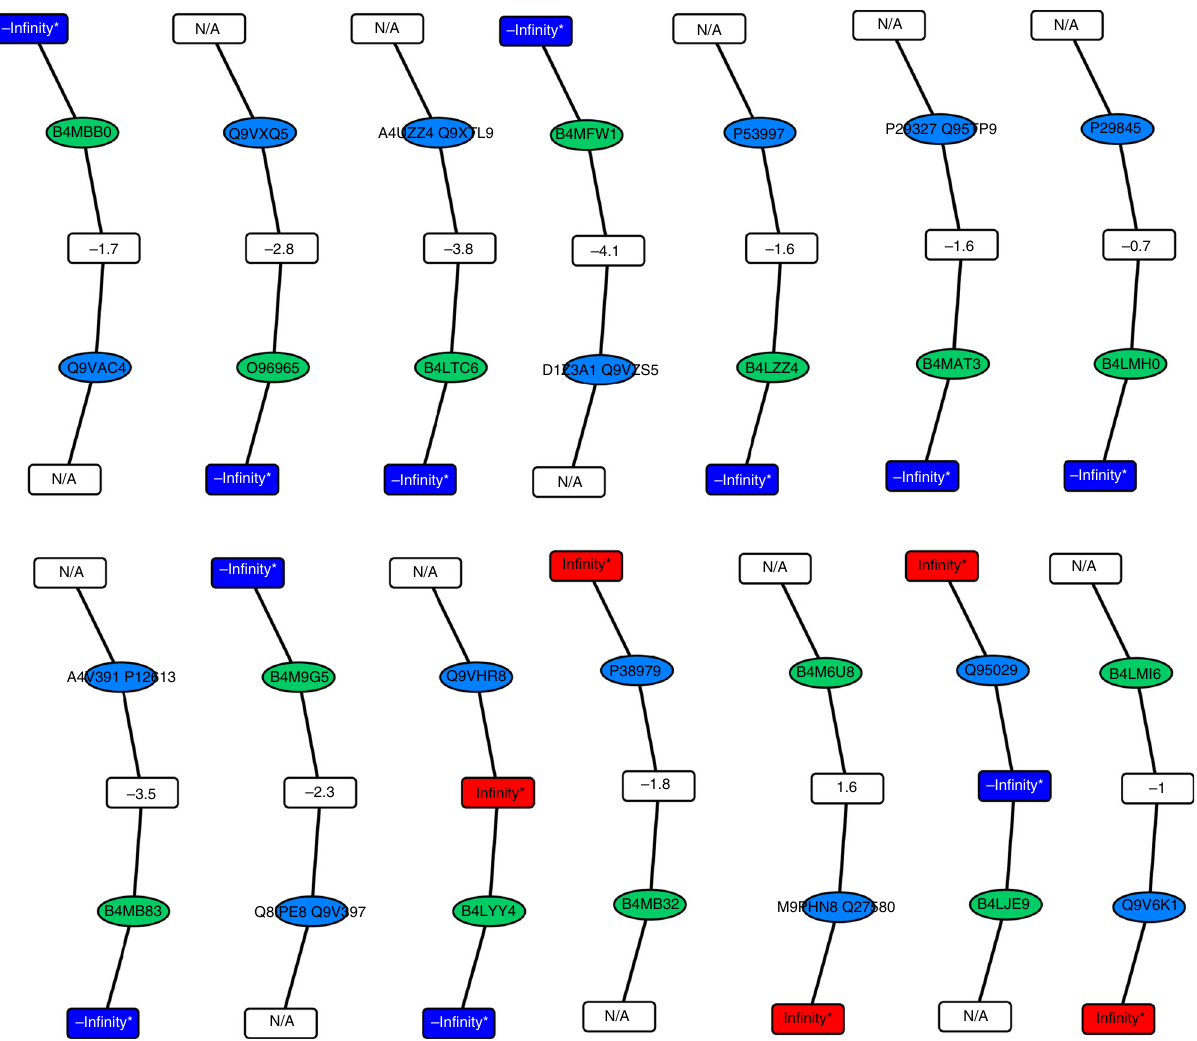
Fig. 5 Fourteen incomplete protein pairs were converted in complete protein pairs upon considering identi fi ed but non-quanti fi ed peptide nodes. Protein pairs of the D . melanogaster (blue ellipses) and D . virilis (green ellipses) protein nodes are shown. The relative peptide abundance (Rc) is indicated in each peptide node. A value indicates a relative log 2 (Rc) abundance in both species, + In fi nity (red rectangles) its presence in only D . melanogaster , – In fi nity (green rectangles) its presence in only D. virilis , and “ N/A ” that the peptide node was solely identi fi ed but not quanti fi ed in its relative